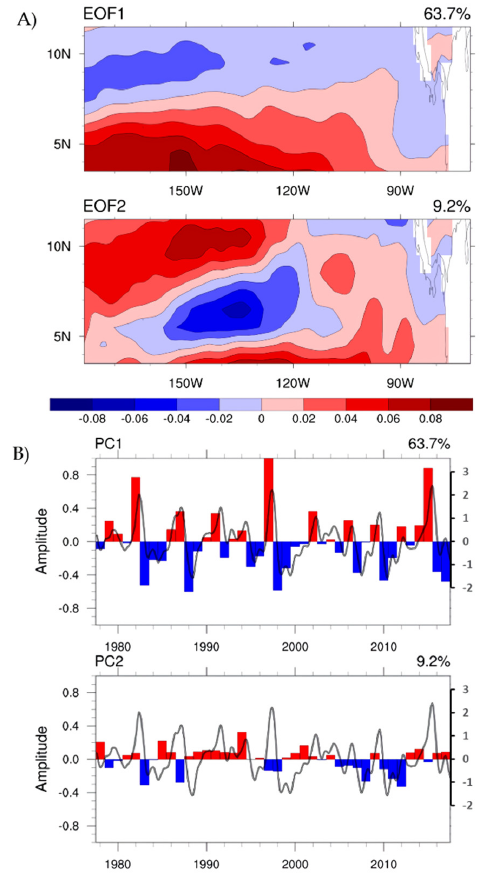
Figure 3. Same as Figure 2, but for fall (SON): ( A ) spatial pattern and ( B ) time series of the principal component superimposed with 6 months low-pass filtered NIÑO 3.4 index. Red and blue bars represented the NECC’s strengthening and weakening, respectively.